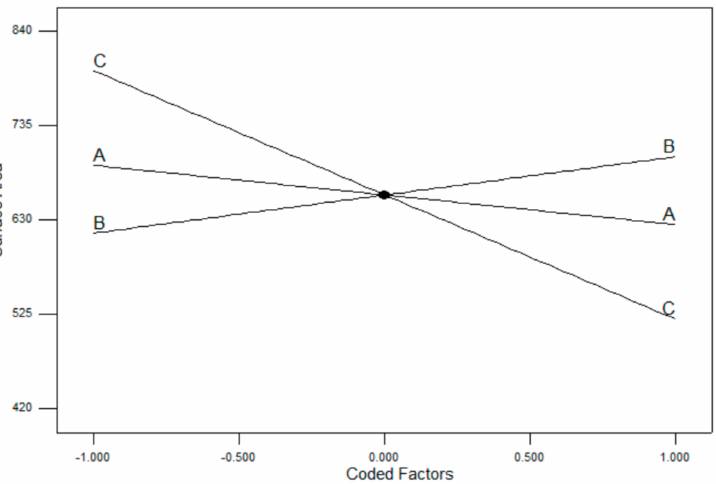
Figure 5. One-factor plot of coded components on the surface area. A: mass of template; B: amount of triethanolamine (TEA); C: reaction